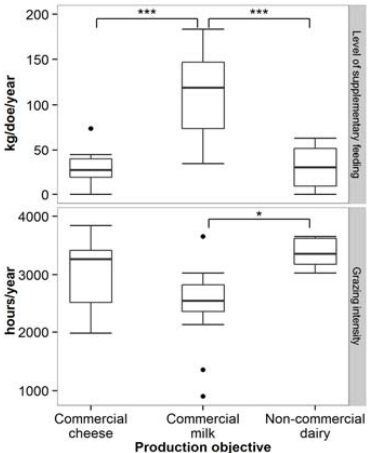
Figure 4. The annual volume of concentrates recevied by does (level of supplementary feeding) and the period of time spent grazing (grazing intensity) on goat holdings in northern Morocco based on monthly data collections between September 2009 and August 2012. Holdings were classified by dairy production status: commercial milk, commercial cheese and non ‐ commercial dairy. Asterisks indicate signficant differences after controlling for repeated measures: * p < 0.05, ** p < 0.01, *** p < 0.001.